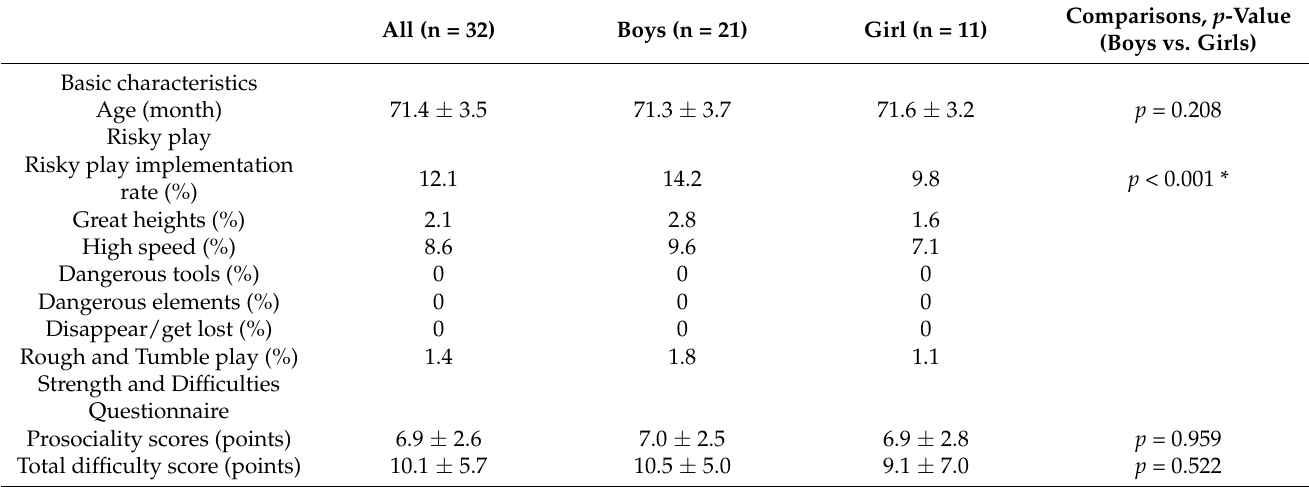
Table 2. Descriptive characteristics of the